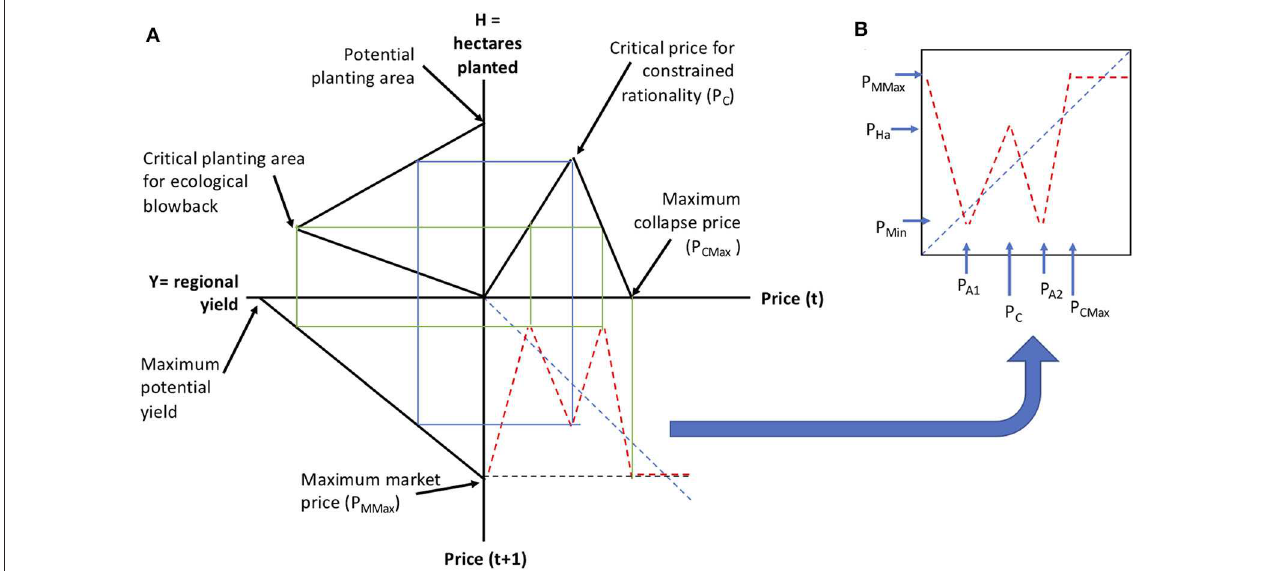
FIGURE 12 | Composed form of the piece-wise linear function approximation to Equation (3). (A) Illustration of the composition process. (B) The resulting composed function.